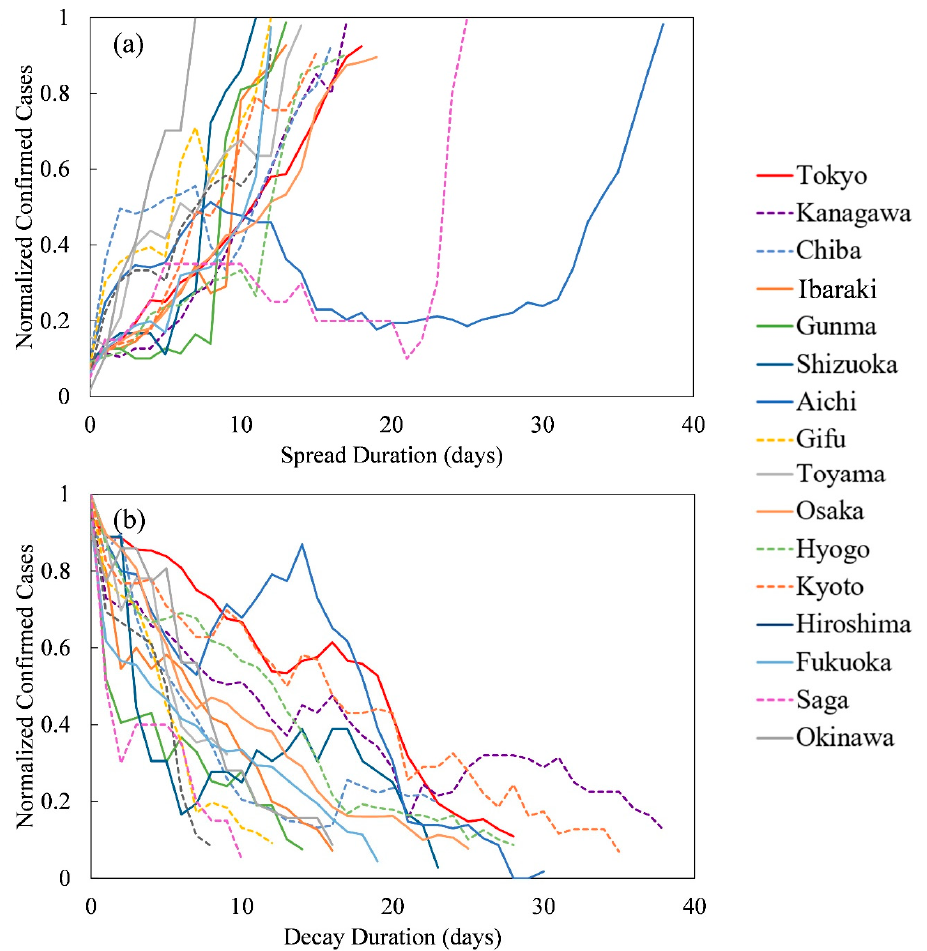
Figure 2. ( a ) Spread and ( b ) decay durations (in days) of 16 prefectures in Japan. Dashed lines represent the prefectures that are adjacent to primary prefectures (Tokyo, Osaka, Aichi, and Fukuoka).